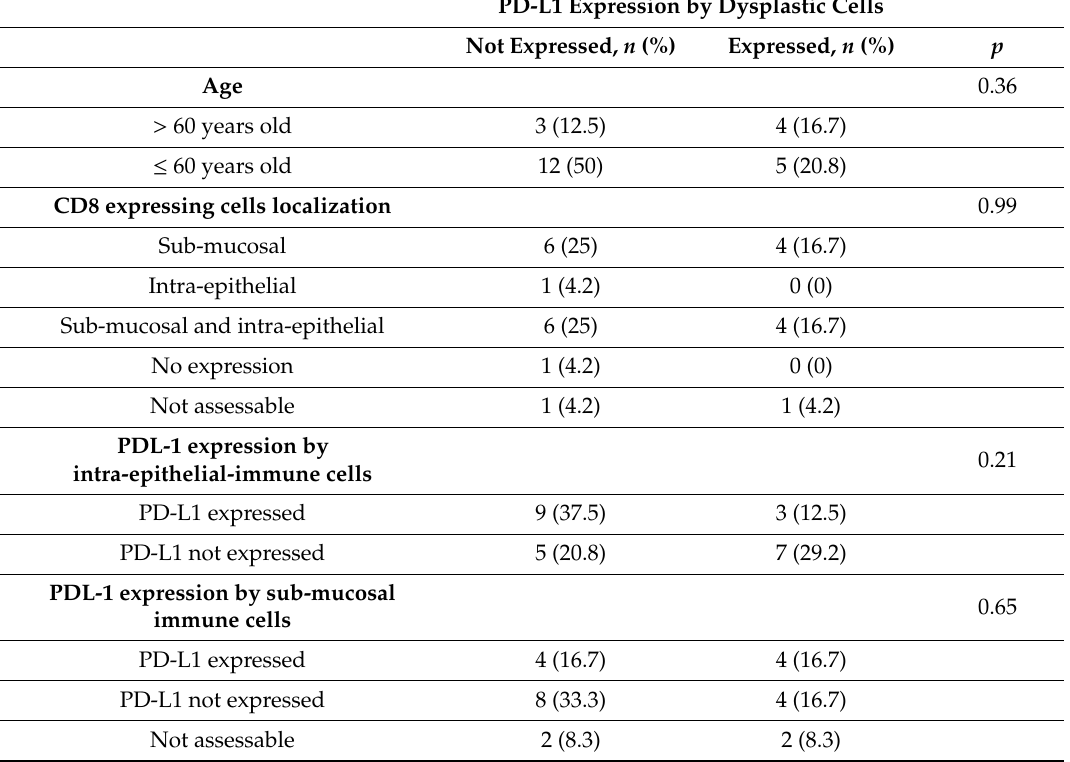
Table 1. Relationship between Programmed Death-Ligand 1 (PD-L1) and CD8 expression in dysplastic neoplasms. PD-L1 Expression by Dysplastic Cells Not Expressed, n